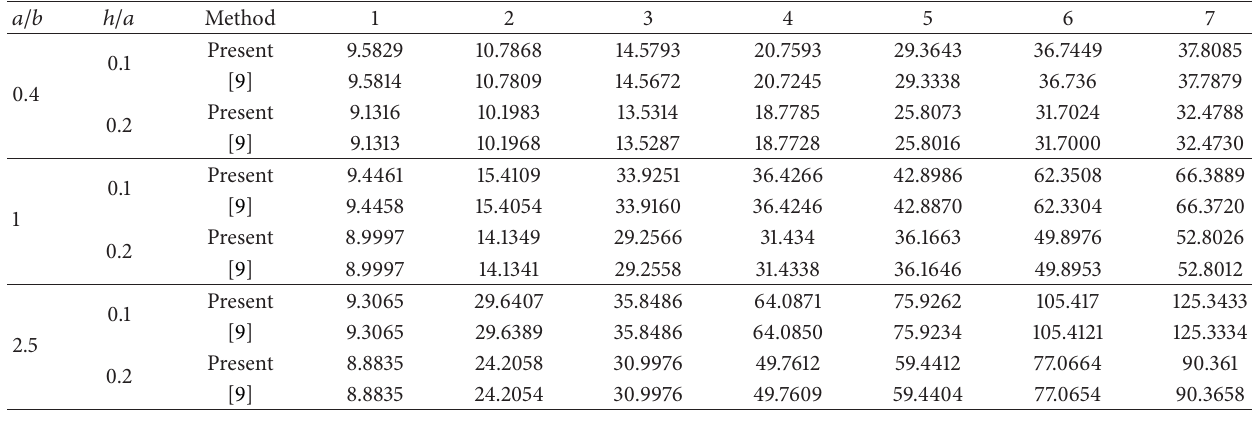
Table 2: The first seven frequency parameters Ω = ( 𝜔𝑎 2 )( 𝜌ℎ/𝐷 ) 1/2 for S-F-S-F Mindlin rectangular